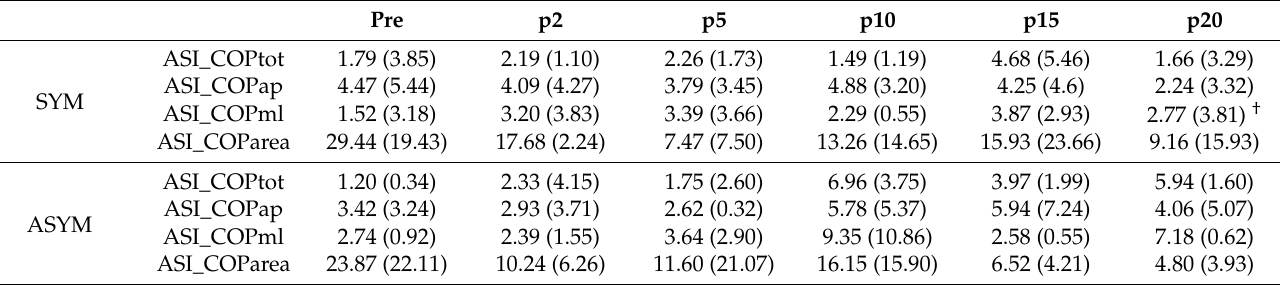
Table 4. ASI indexes in the SYM and ASYM